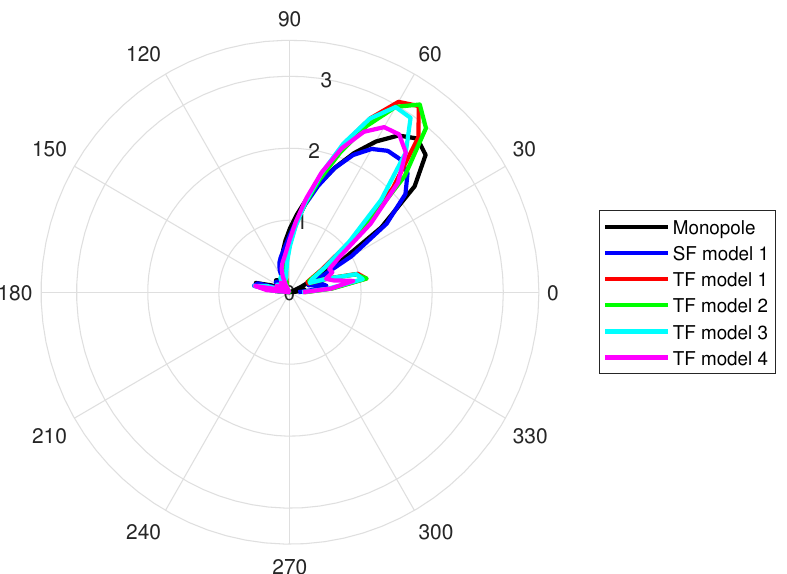
Figure 12. Directivity of the antennas at the resonance frequency in spherical coordinates at φ =